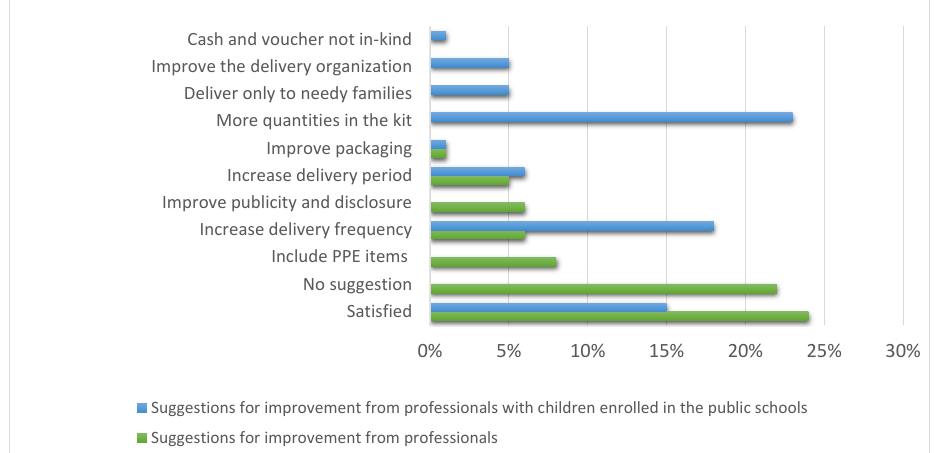
Figure 6. Professionals’ suggestions for improvement.